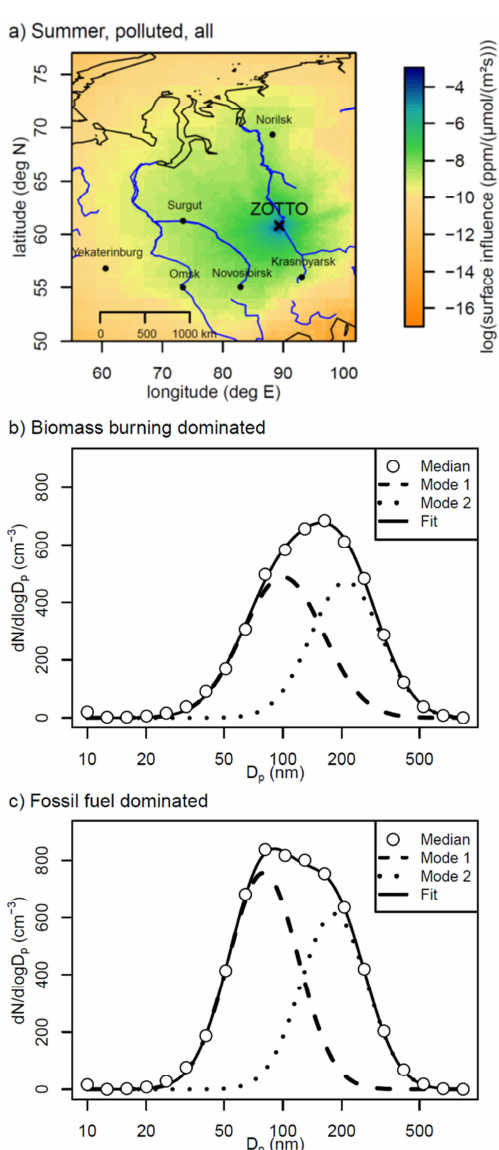
Figure 7 a) Footprint of summer polluted periods with the aerosol size distributions for b) biomass burning dominated Fig. 7. (a) Footprint of summer polluted periods with the aerosol and c) fossil fuel dominated pollution periods. size distributions for (b) biomass-burning-dominated and (c) fossil- fuel-dominated pollution